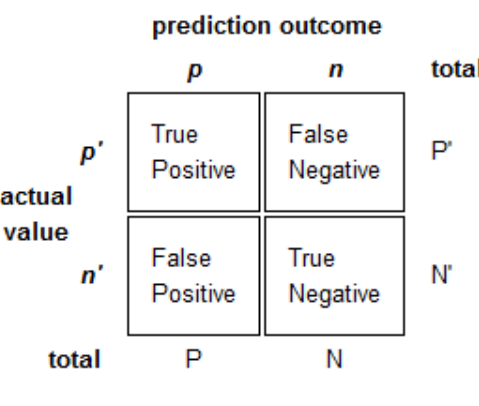
Figure 4. Confusion matrix